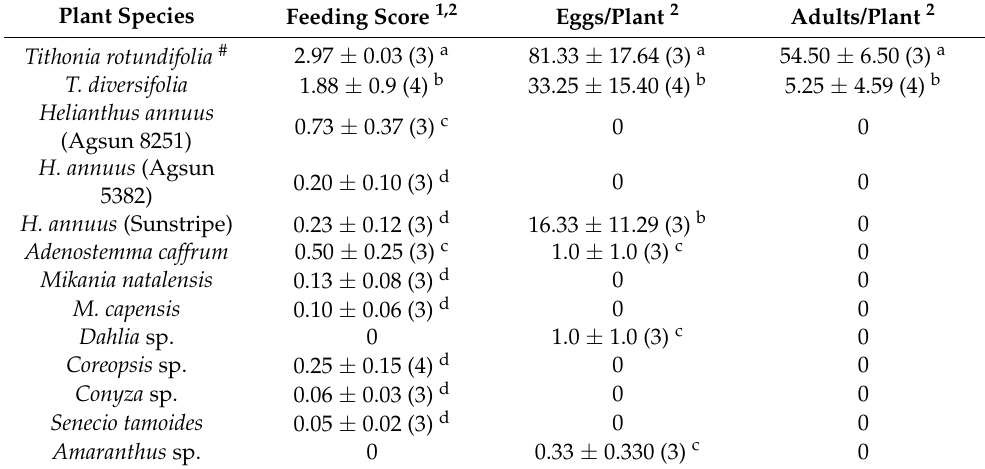
Table 3. Mean ± SE (n) feeding damage rating, oviposition and number of adult progeny produced by Zygogramma signatipennis adults on test-plant species that supported feeding and oviposition during the no-choice tests.